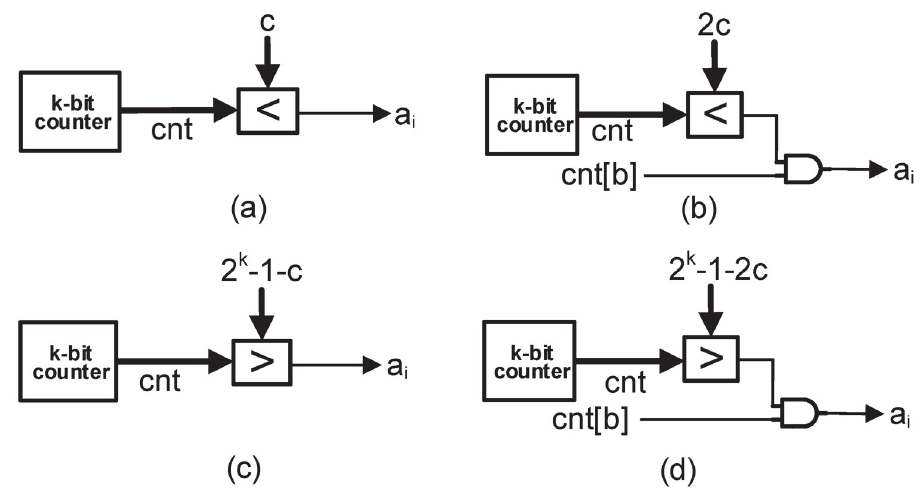
Fig 6. Proposed circuits for uniform pattern generation. (a) Circuit for generating a pattern of ‘1111 ... 0000 ... ’, (b) Circuit for generating rest of the patterns using a particular bit of counter, (c) and (d) Circuits for generating the Shifted version of the patterns in (a) and